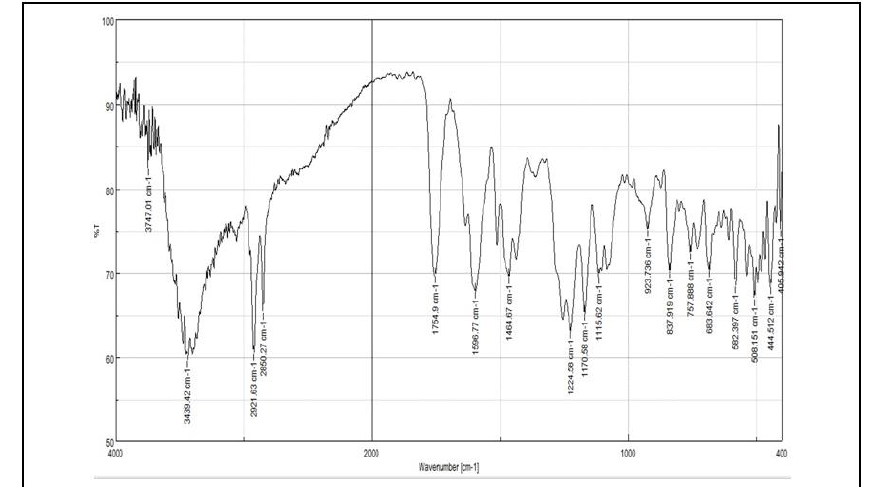
Fig. 6. FT-IR spectrum of PF polyester